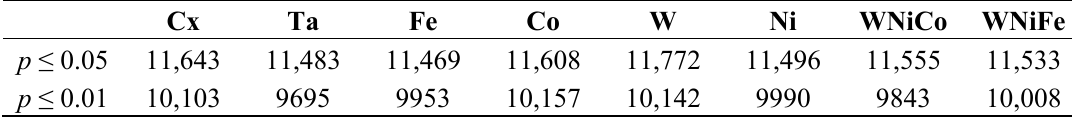
Table 3. Mouse data comparison between actual numbers of features accurately expressed in each exposure group at the detection p -value ≤ 0.05 and ≤ 0.01.